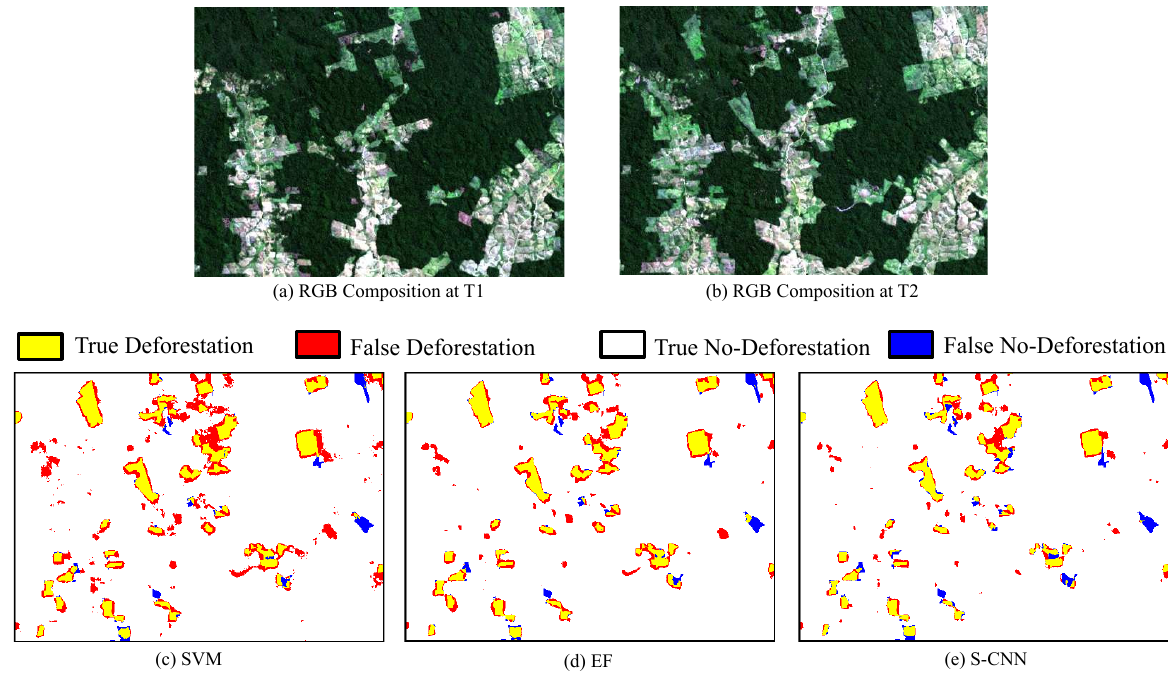
Figure 9. RGB composition and the change maps predicted by SVM, EF and S-CNN on the tile number fourteen, which is part of the test